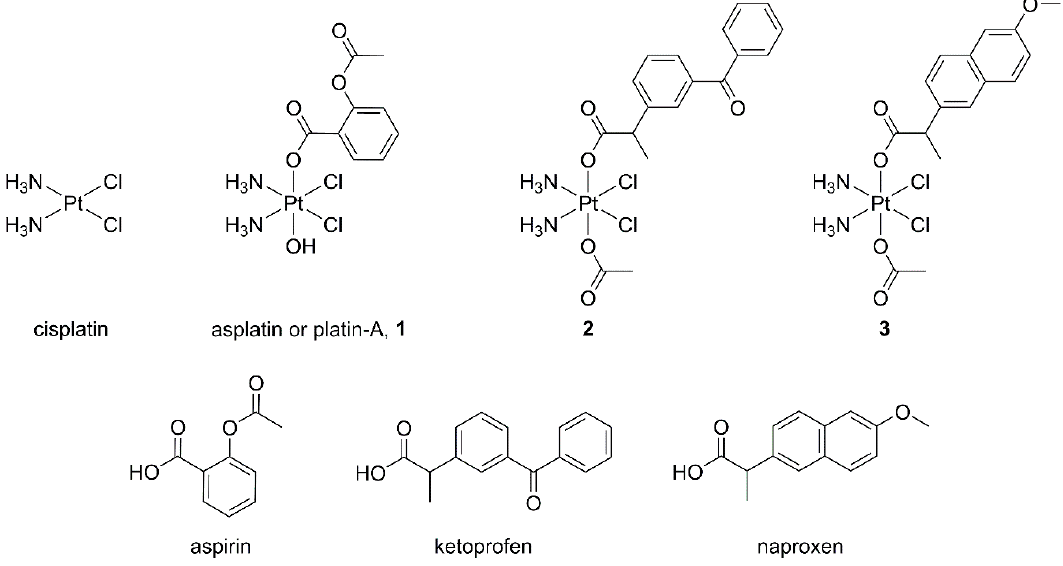
Figure 2. Sketch of the compounds under investigation.